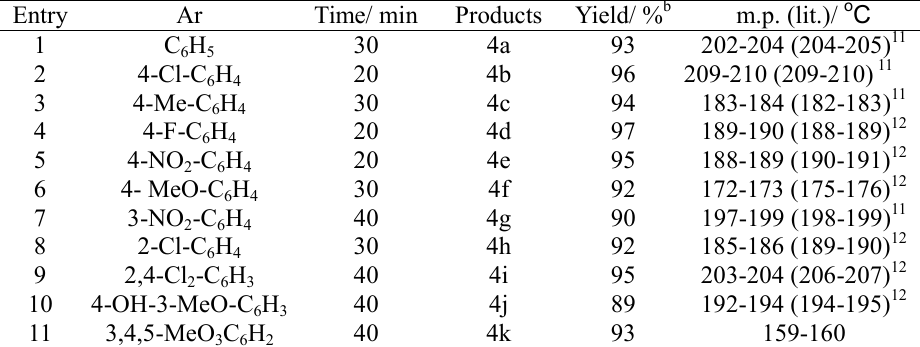
Table 2. Preparation of 2'-aminobenzothiazolo-arylmethyl-2-naphthols a